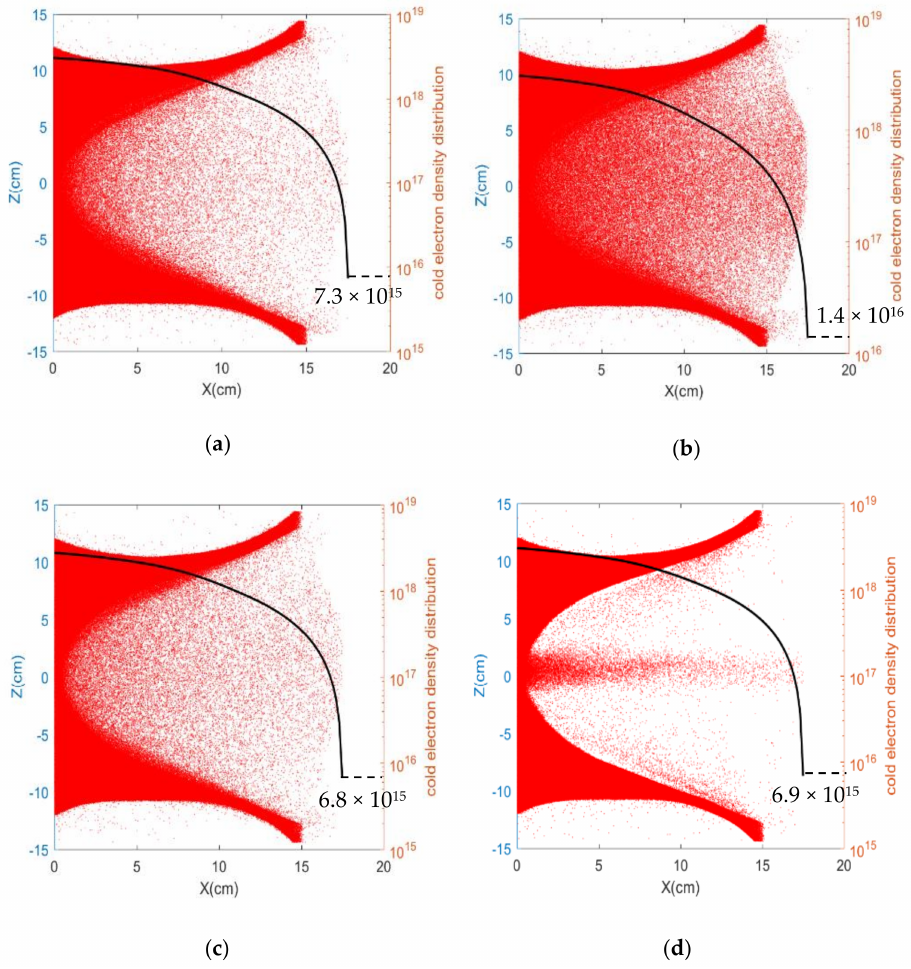
Figure 8. The spatial distribution of “cold” electrons on the X − Z plane and the average density distribution along +X direction under four reaction types at T = 15 µ s. The red dots represent the “cold” electrons ( ε ≤ 2 eV). ( a ) Type-A. Elastic (index:1); ( b ) Type-B. Elastic and excitations (index:1,9–18); ( c ) Type-C. All collisions (index:1–19); ( d ) Type-D. No